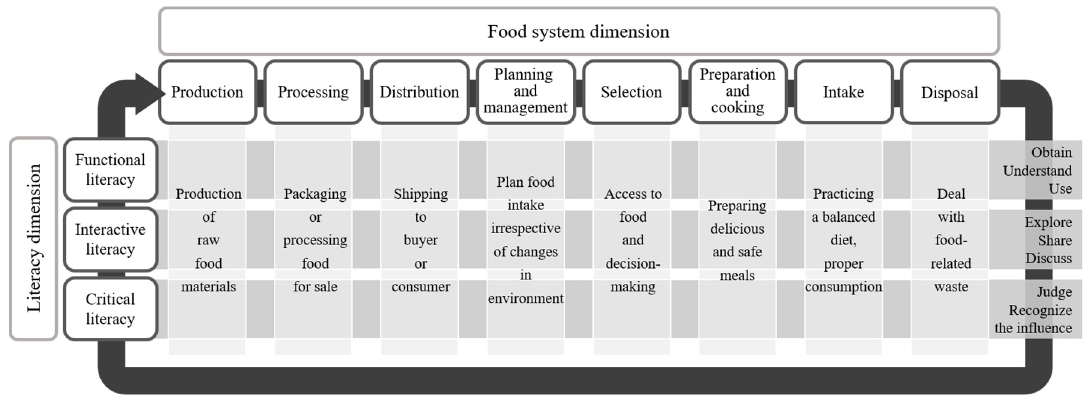
Figure 1. Food literacy conceptual framework derived from the literature review.